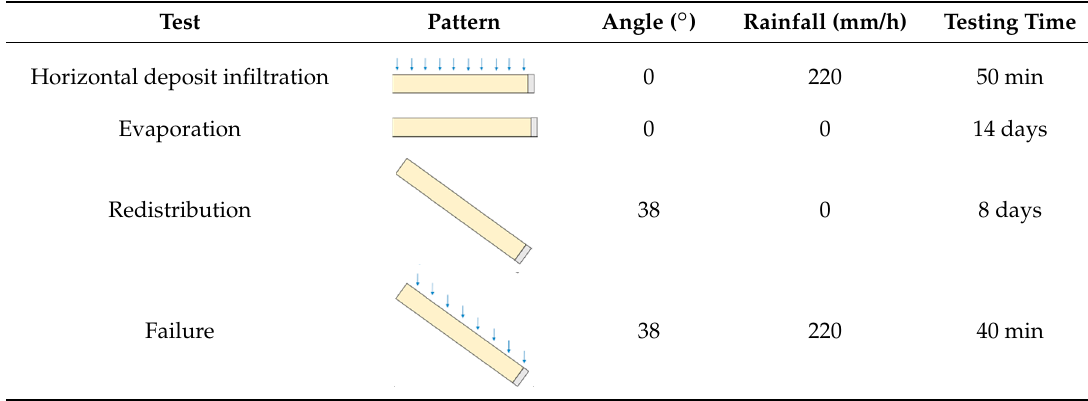
Table 3. Main characteristics of the various test phases.